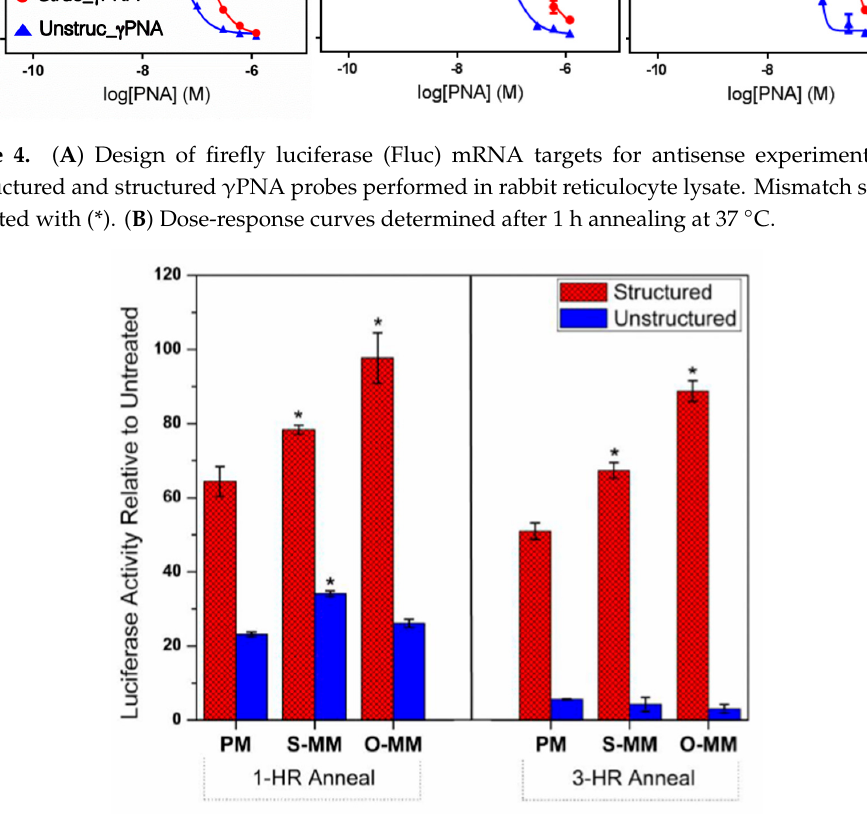
Figure 5. Effect of annealing time on antisense target discrimination. Samples contained 10 nM mRNA and 100 nM γ PNA. Fluc activity was compared to control samples lacking either γ PNA probe and are expressed as a percentage of activity on the y -axis. At a 1 h annealing time (left panel), the struc_ γ PNA demonstrated a statistically significant (* = p < 0.05) difference in luciferase inhibition between the perfect match (PM) and both mismatch targets, whereas the unstruc_ γ PNA only showed a significant difference between the PM and S-MM-7U. At a 3 h annealing time (right panel), there was no inhibition difference ( p > 0.05) amongst the three targets when using the unstruc_ γ PNA, whereas the struc_ γ PNA retained discrimination of the mismatched targets. All data shown are presented as an average of n = 3 ± SD.